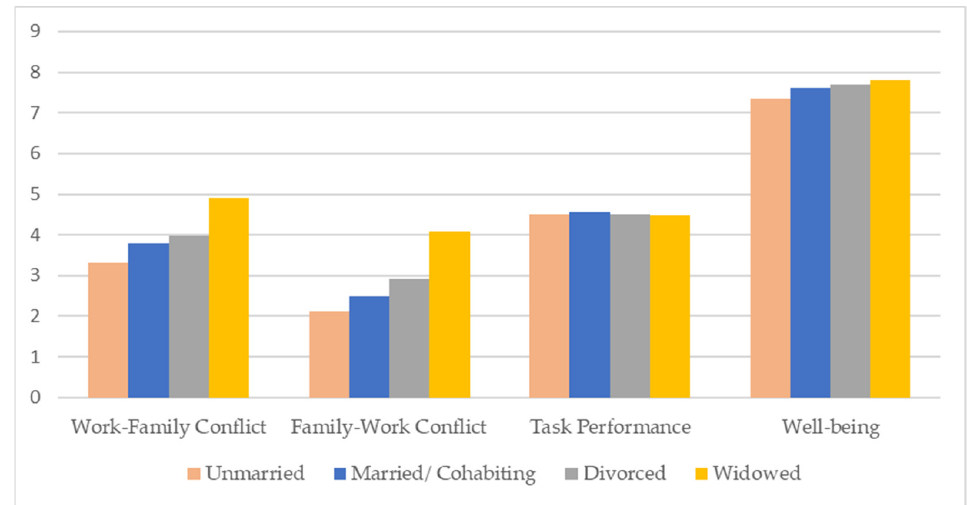
Figure 4. Distribution of variables by marital status .